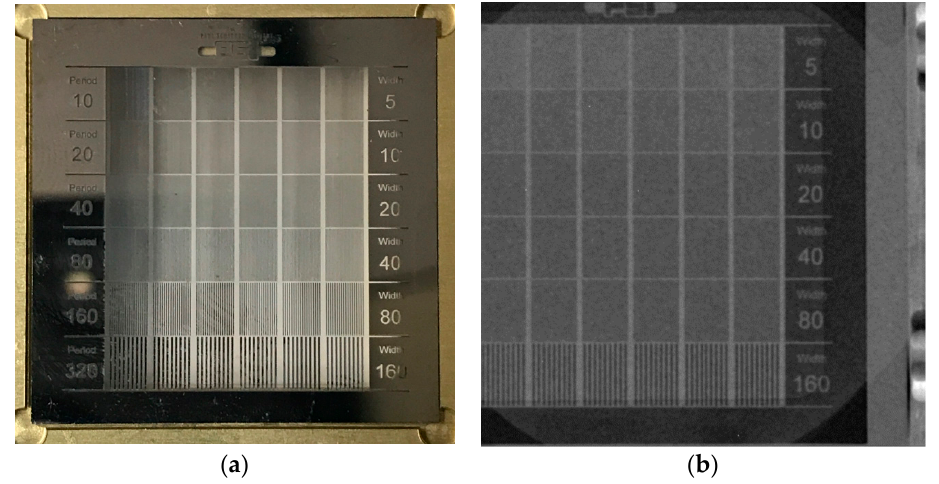
Figure 6 . Photograph of PSI resolution grating ( a ). Non-centroided neutron image of the PSI resolution grating, comprised of SiO 2 glass backing and 5 μ m thick Gd absorber with laser-etched test patterns ( b ) [33,37].